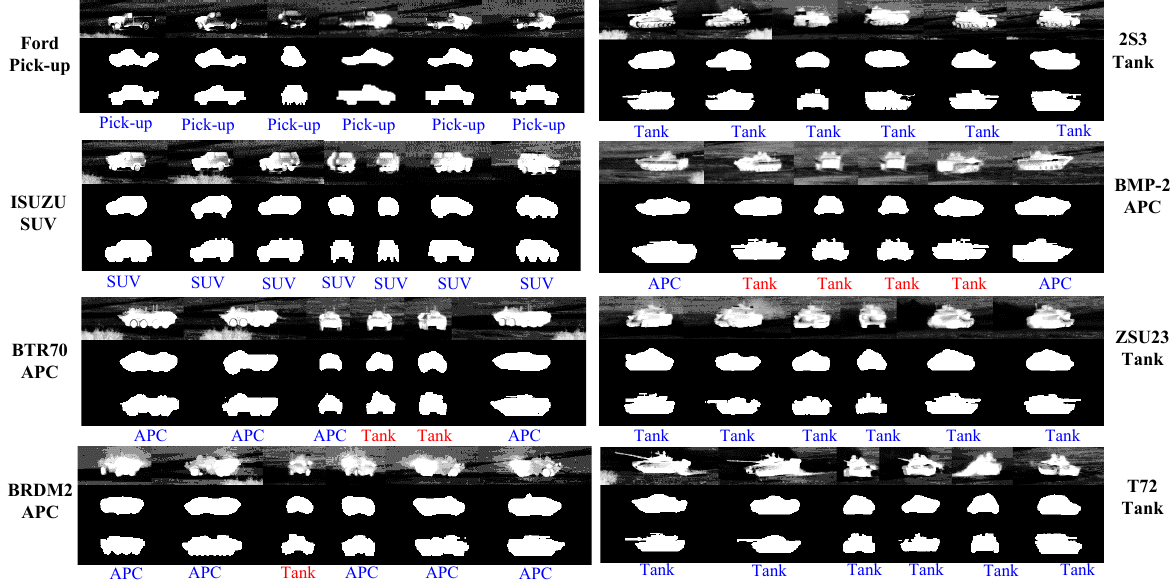
Figure 12. Some GB-PSO results for pose estimation and recognition results of eight targets under a 1-km target-sensor range from the SENSIAC database. For each target, from the first row to the third: original IR frame, level set segmentation-based initialization and the final pose estimation and recognition results from GB-PSO. Recognition results are denoted in blue if correct and red if wrong below each